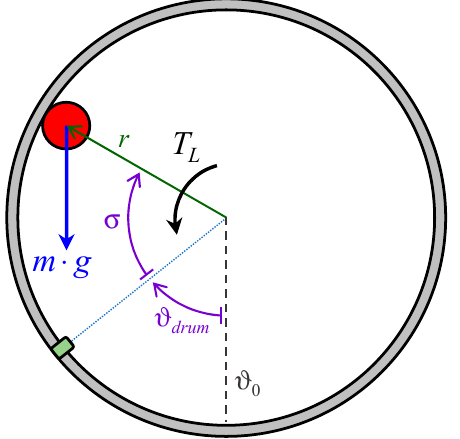
Figure 4. Model of the laundry unbalance for a horizontal-axis washing machine.